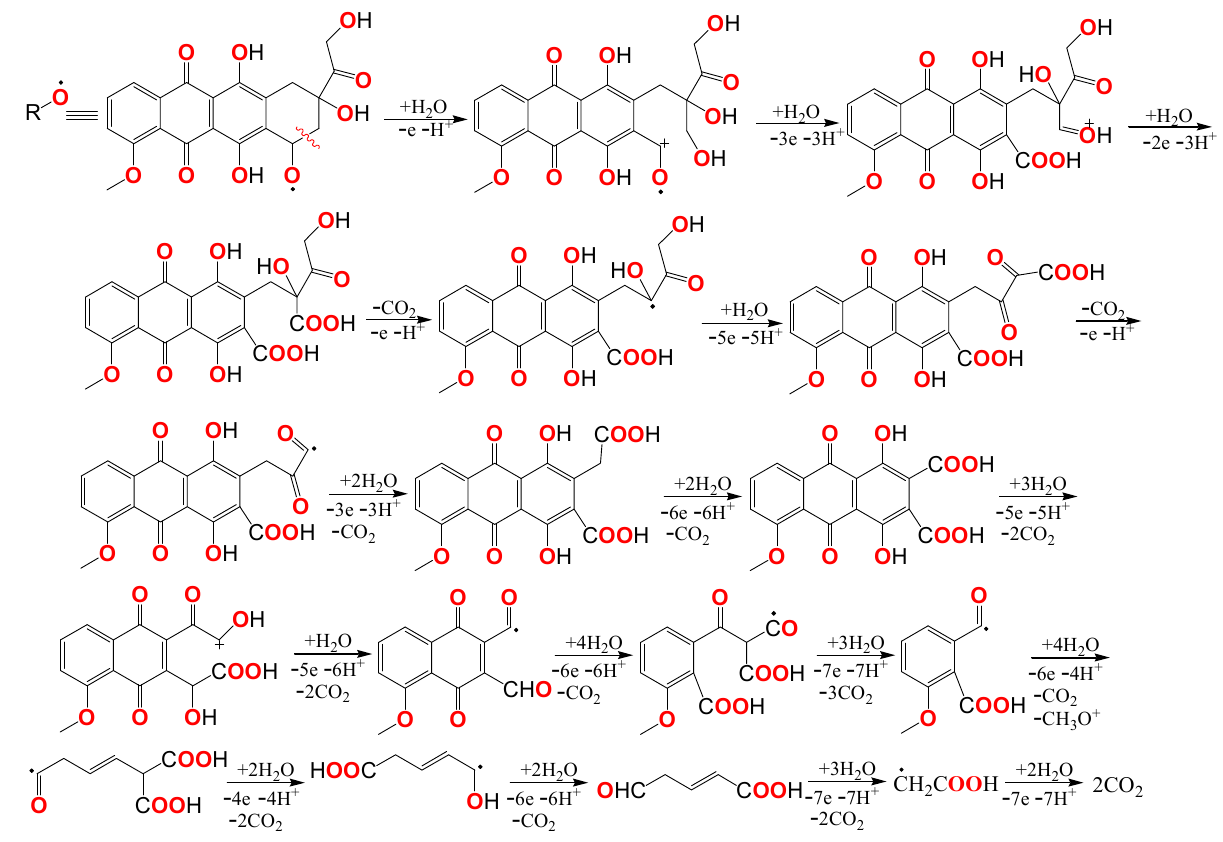
Scheme 2. Final degradation of tetracene